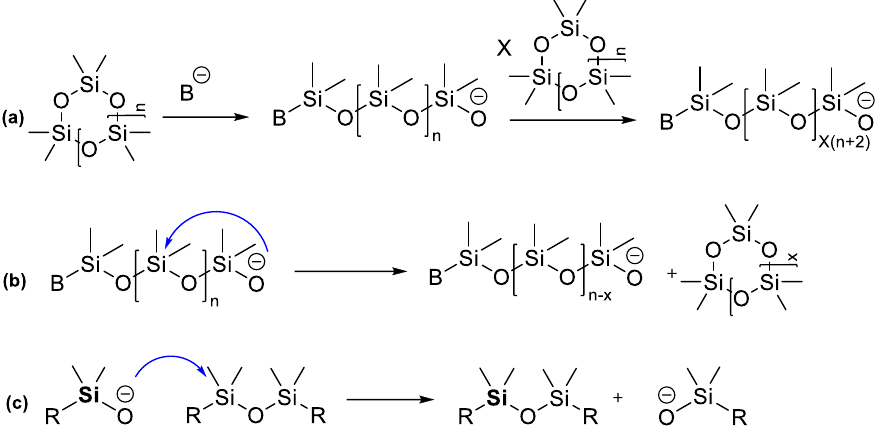
Figure 2. AROP of cyclosiloxanes: ( a ) initiation reaction by formation of silanolate anions and propagation, ( b ) back-biting reaction on a growing PDMS chain; ( c ) chain-transfer reaction.